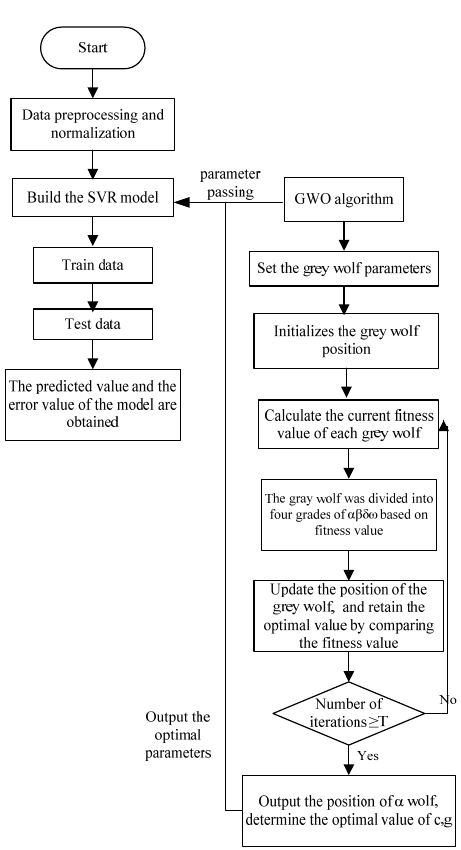
Figure 2. Flow chart of GWO-SVR.